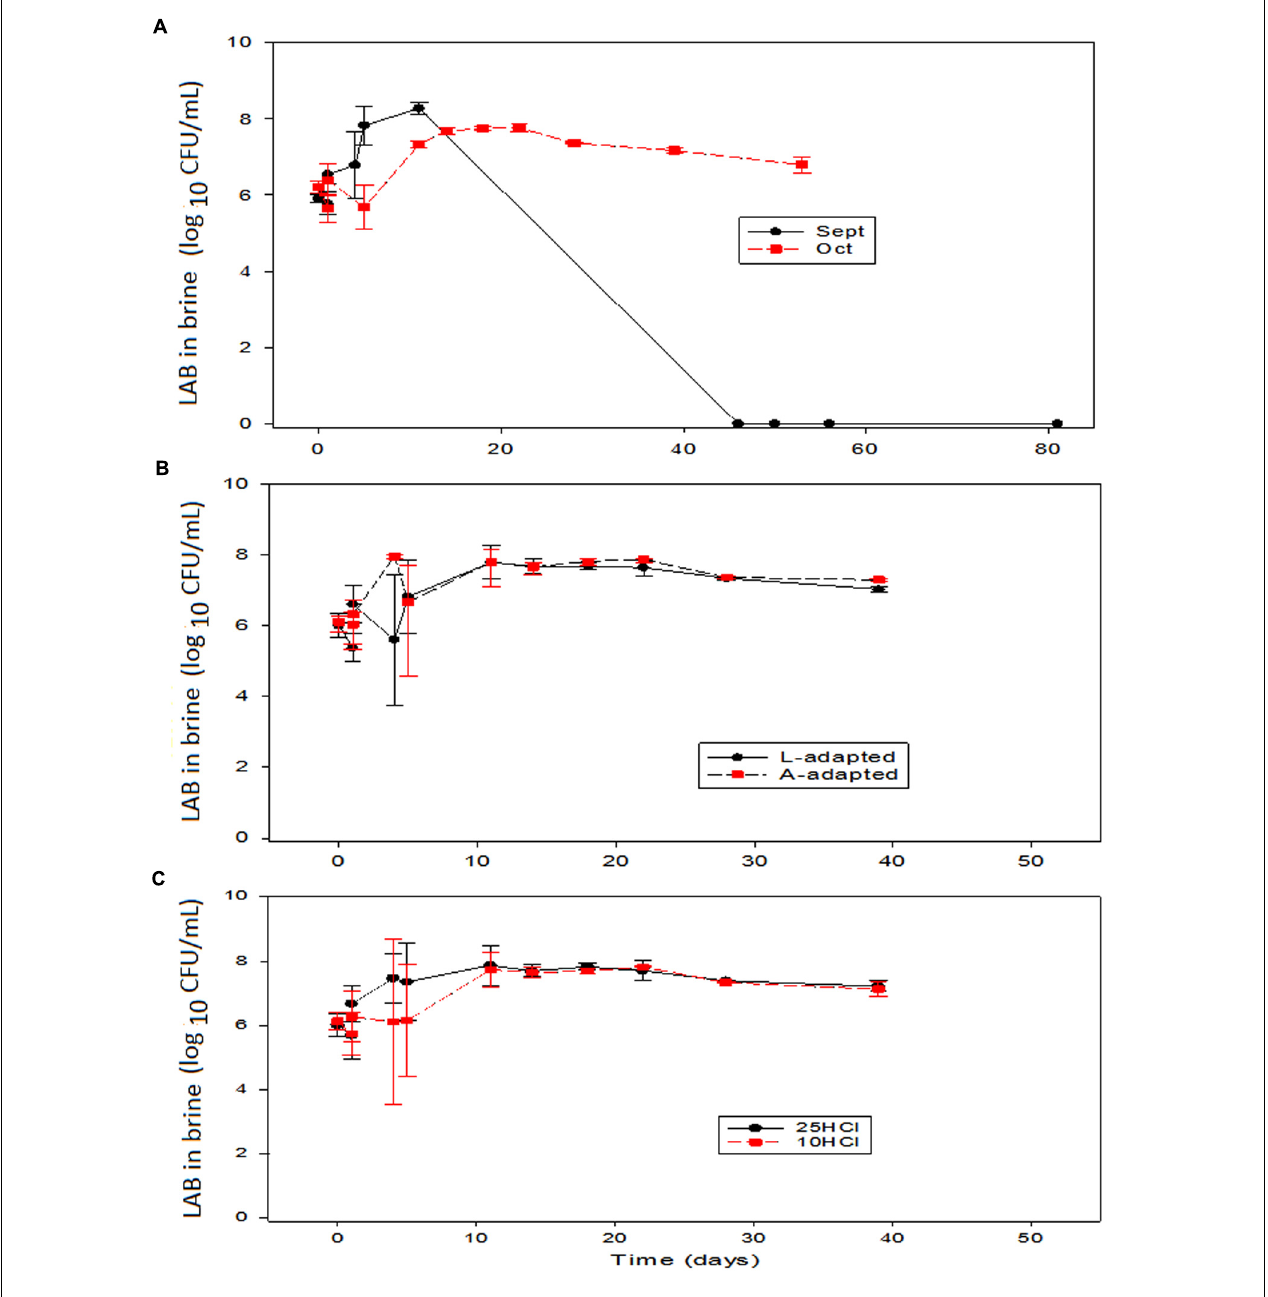
FIGURE 4 | Application of potential probiotic starter (LAB2) at industrial scale (season 2012/2013). Changes in LAB in brine ( ± CL, n = 4 for each level) according to time season (A) , type of inoculum (B) , and proportion of HCl added to fermentation vessels (C) . The values are always averages over the other two non-included in the graph variables. See Figure 1 for the meanings of